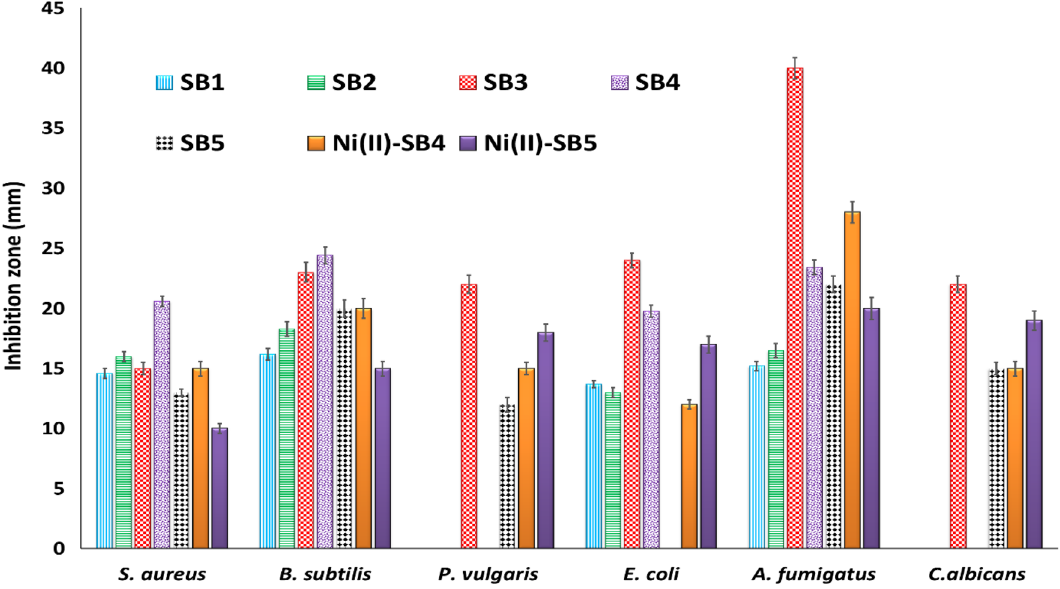
Figure 16. Inhibition zone (mm) of the synthesized compounds against selected